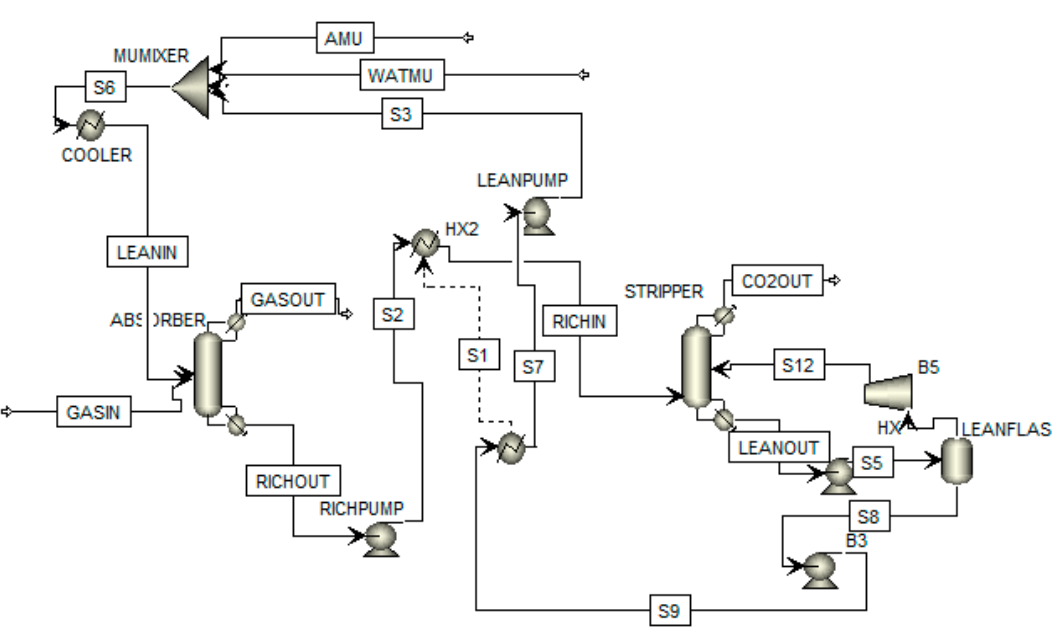
Figure 2. Lean amine flash modification [12]. Figure 2: Lean amine flash modification [12] Table 4. Results for lean amine flash